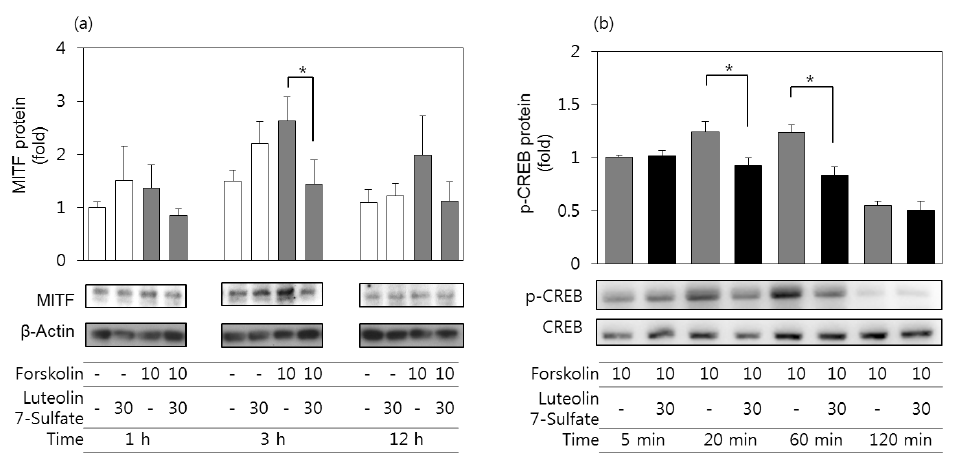
Figure 4. Effects of luteolin 7-sulfate on the protein levels of microphthalmia-associated transcription factor (MITF) and the phosphorylation of cAMP-responsive element binding protein (CREB). B16-F10 cells were pretreated with 30 µ M luteolin 7-sulfate and stimulated with 10 µ M forskolin for the indicated time. Western blotting was performed for MITF and β -actin ( a ), and for phospho-CREB (Ser 133 ) and total CREB ( b ). The means ± SEs of three independent experiments are presented. * p < 0.05.